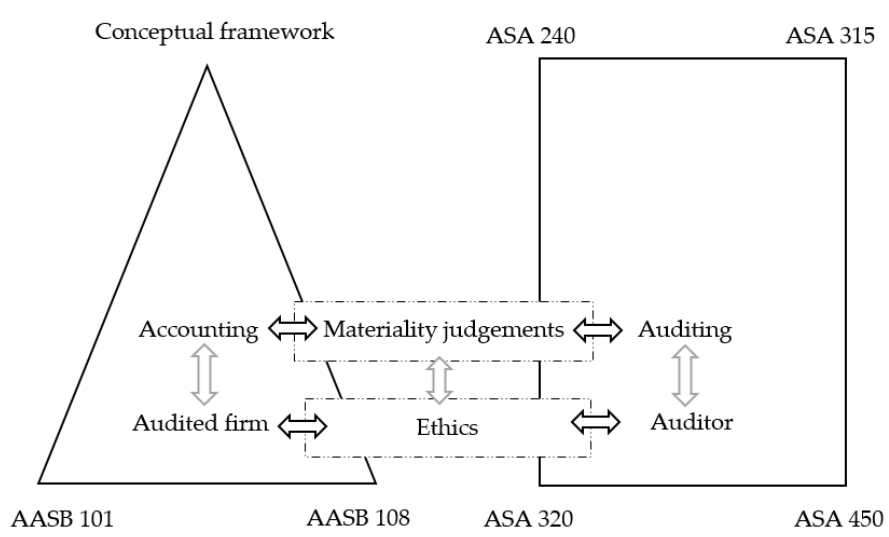
Figure 2. Interconnection between accounting and auditing pronouncements about materiality judgements.